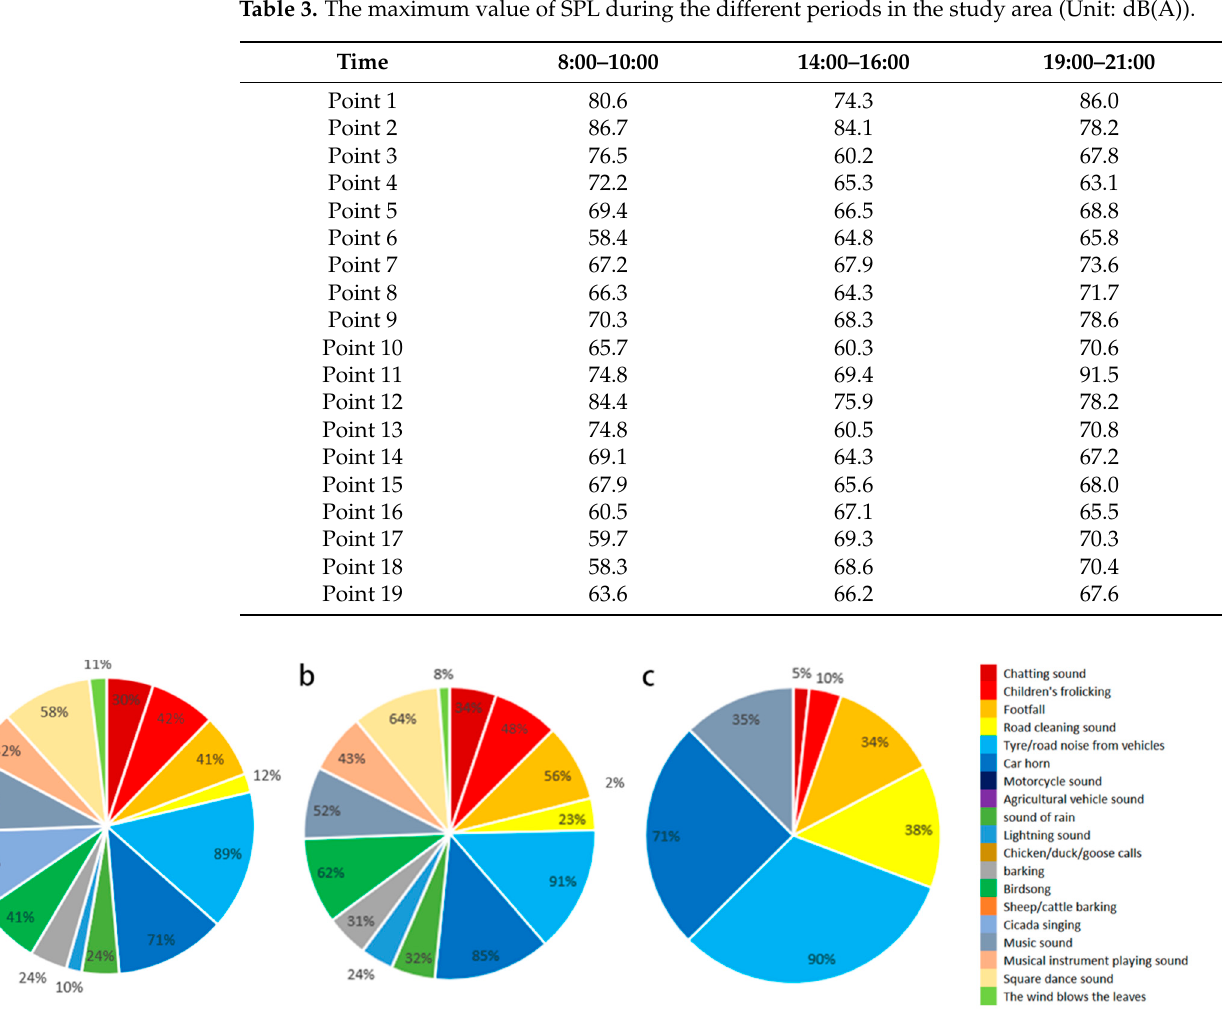
Figure 4. Outdoor sound frequency diagram of an old residential area: ( a ) summer; ( b ) spring and autumn; ( c ) winter.